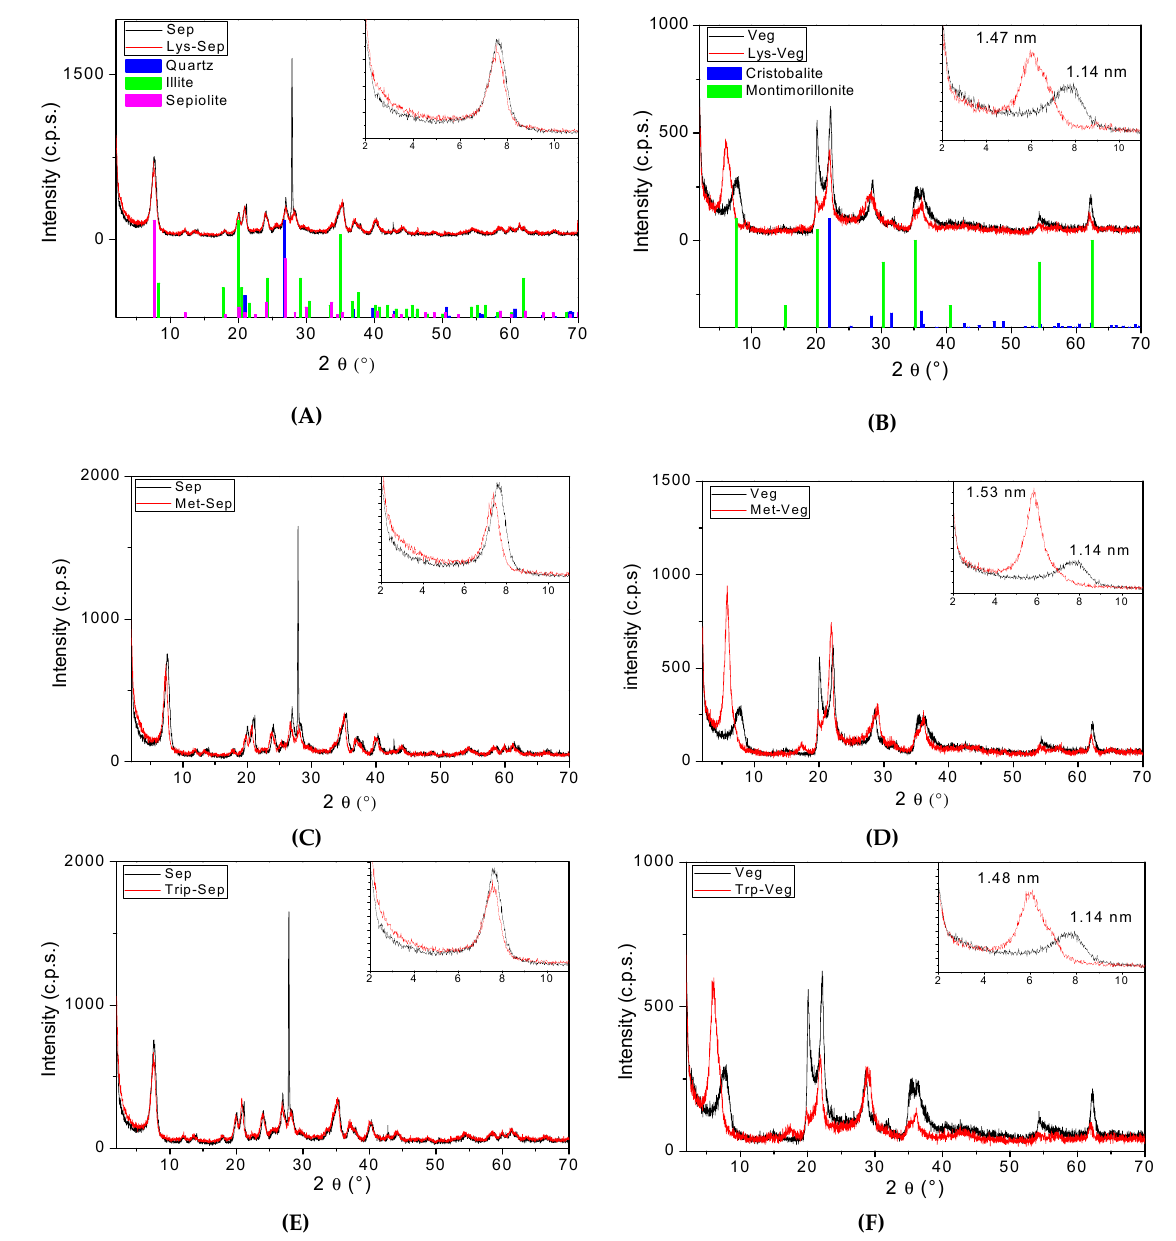
Figure 1. X-ray diffractograms for Sep and Veg clay mineral before and after adsorption incorporation of ( A , B ) L-lysine; ( C , D ) L-methionine; ( E , F ) L-tryptophan. The respective diffraction patterns for the JCPDS indexed to each diffractogram are shown in ( A , B ).